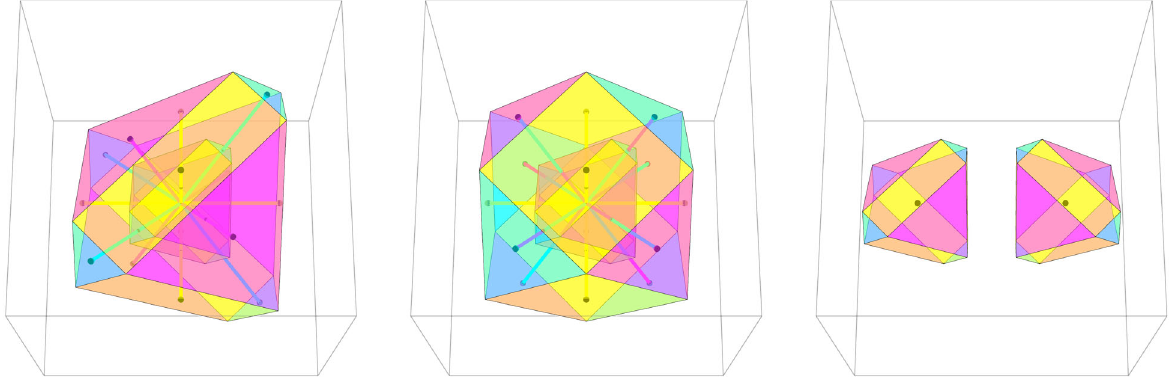
FIG. 1 The sum body (left) and difference body (middle) for a noncentrally symmetric polyhedron. A Kuperberg pair for the same polyhedron